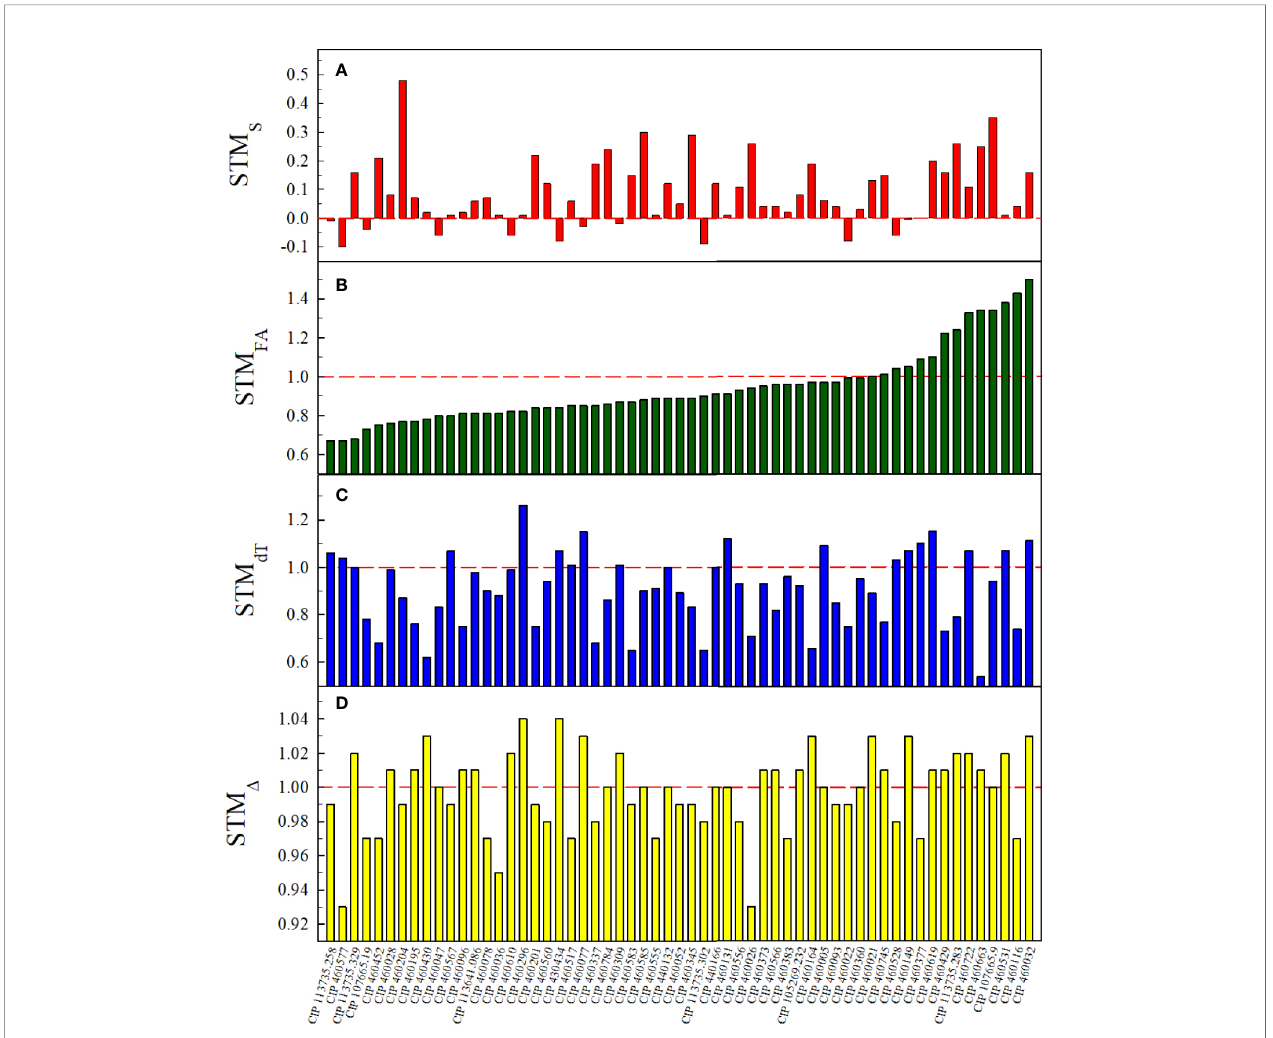
FIGURE 2 | Short-term memory (STM) values per accession for senescence (STM S ) (A) , foliar area (STM FA ) (B) , leaf-minus-air temperature (STM dT ) (C) and leaf 13 C discrimination (STM D ) (D) . Red dashed line indicates STM